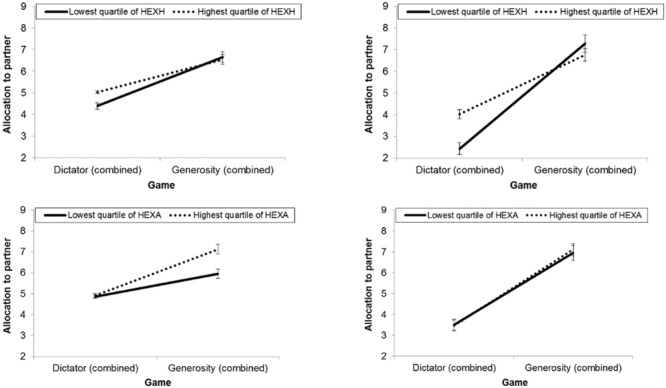
Comparison of game allocations between the highest and lowest quartiles of HEXACO Honesty-Humility and HEXACO Agreeableness. (Left) Study 1 (hypothetical), (right) Study 2 (incentivized). Data are collapsed across reciprocity conditions. Error bars represent one standard error. N = 304 (Study 1), 256 (Study 2).